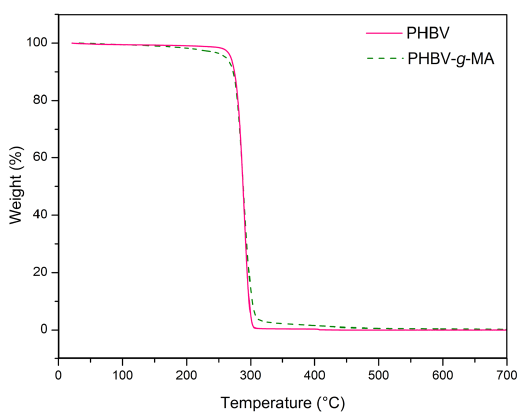
Figure 4. Thermal degradation of neat PHBV and PHBV- g -MA.